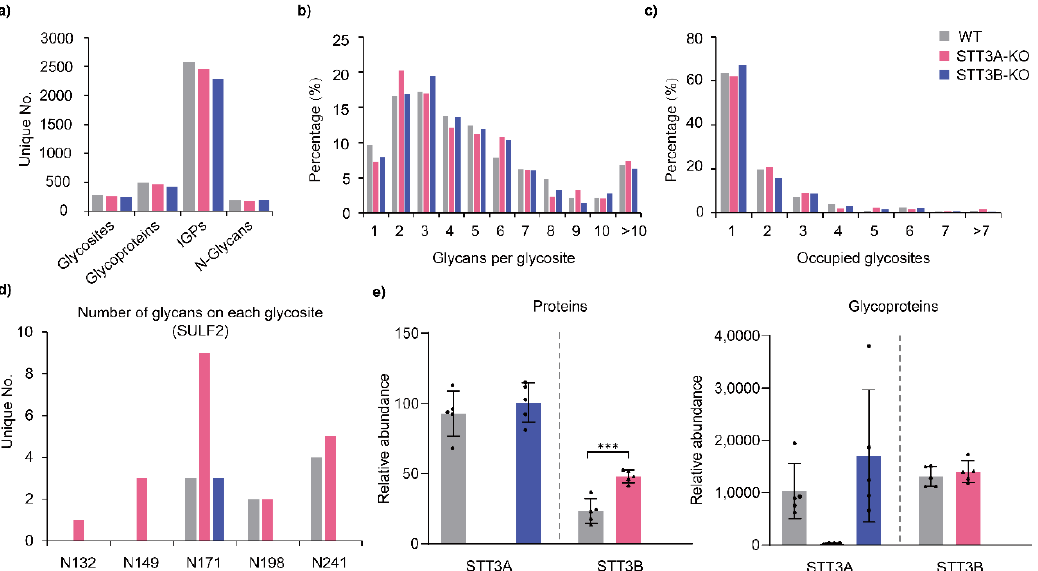
Figure 2. Glycoprotein analysis in WT and KO cells. ( a ) Numbers of identified glycosites, glycopro- teins, IGPs, and N-glycans. Numbers of glycans per glycosite ( b ) and glycosites per protein ( c ). ( d ) Number of glycans on each glycosite of extracellular sulfatase Sulf-2 (SULF2). ( e ) Relative abun- dance of STT3A and STT3B proteins in WT and KO cells. STT3A and STT3B protein abundance in global protein (left) and glycoprotein (right) analyses are shown as bar plots. ***, p -value < 0.001.